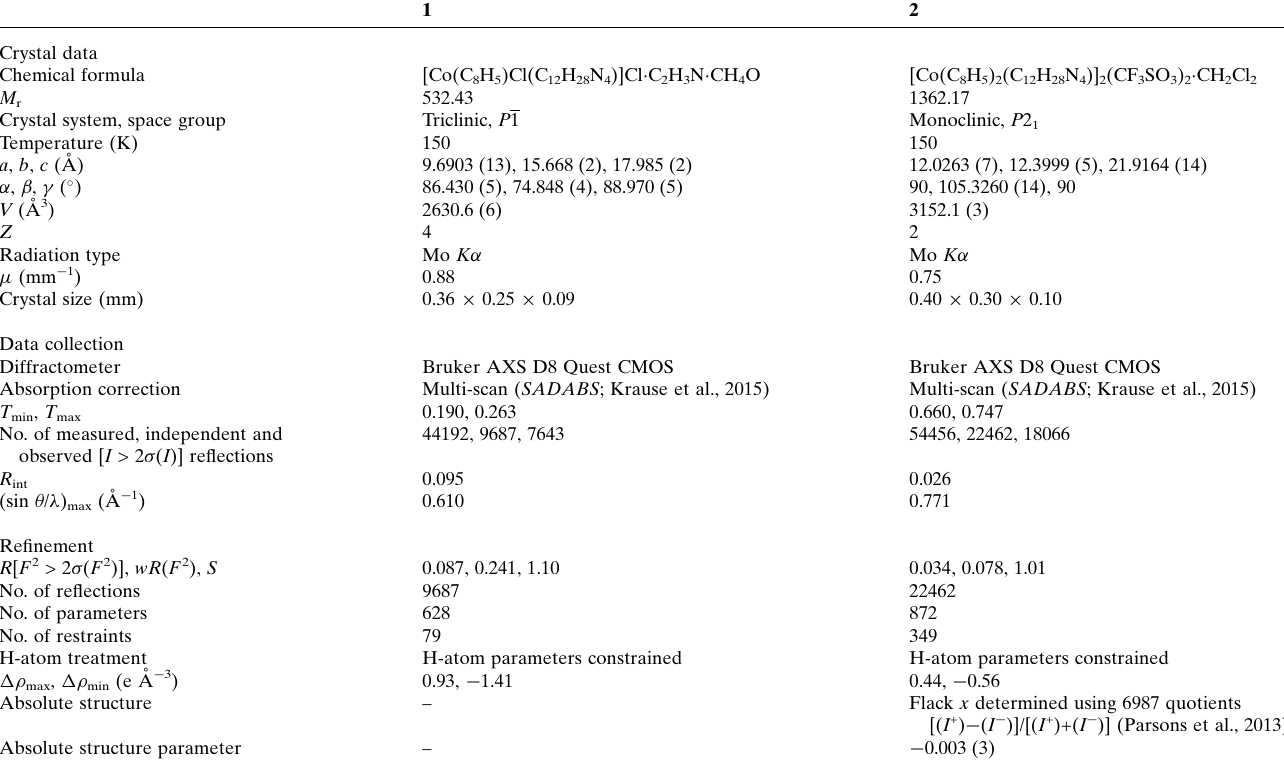
Table 5 Experimental details.